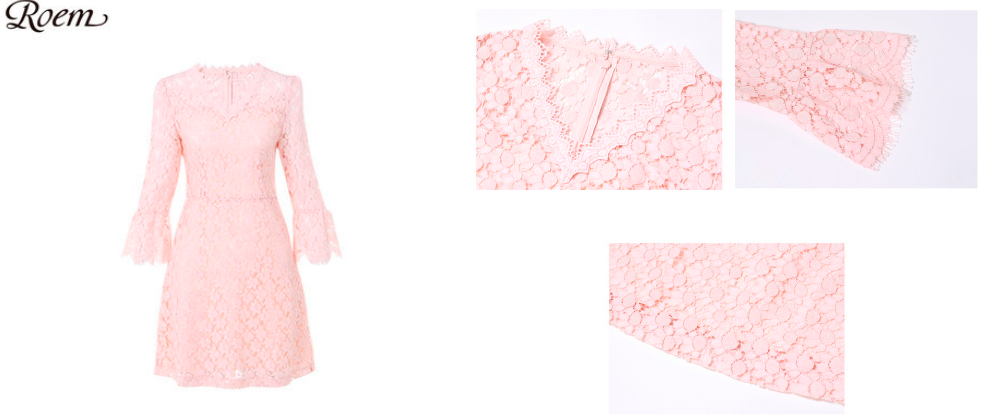
Figure 3. Some of the information about the product from the Taobao platform.